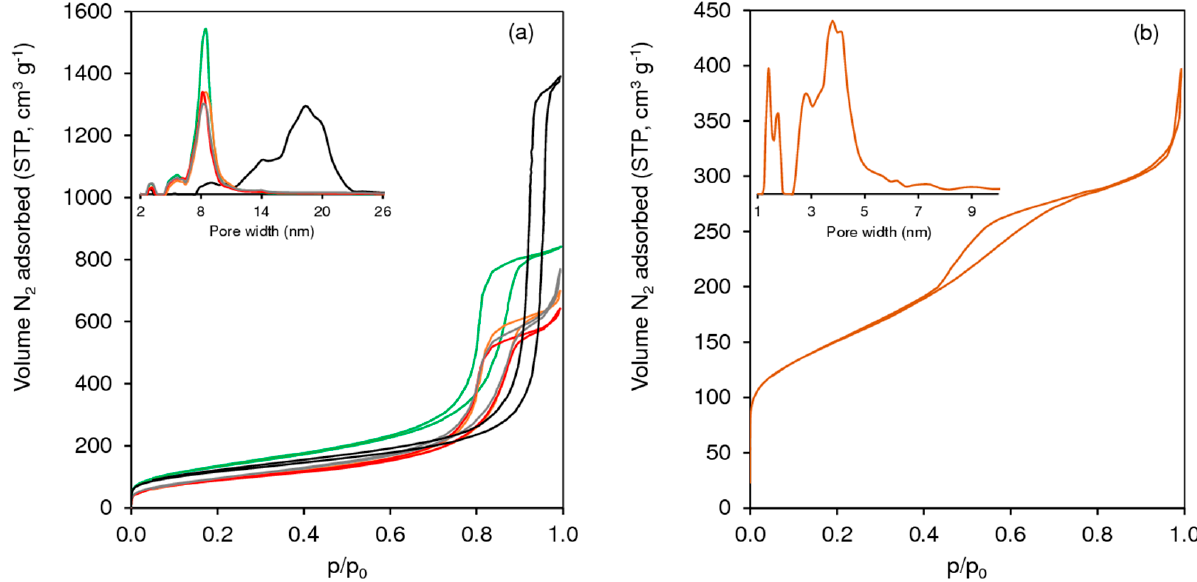
Figure 4. Nitrogen sorption isotherms at − 196 °C of ( a ) TUD-1(PT) (green), Mo-TUD(IWI-acac) (grey), Mo-TUD(IWI-ahm) (red), Mo-TUD(IWI-amm) (orange), Mo-TUD(HT) (black), and ( b ) Mo-hierBEA. The insets show the respective pore size distributions (with matching colors). Table 1. Composition and textural properties of the prepared materials.